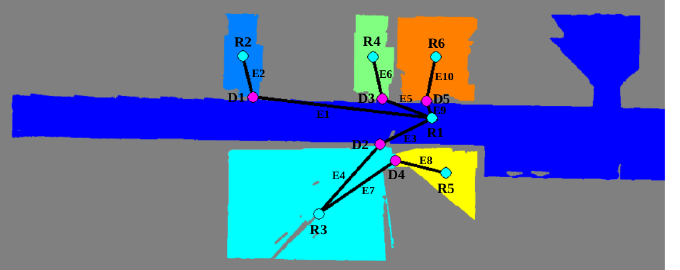
Figure 20. Resulting topological map overlapped with the segmented scenario. R and D correspond to room and door nodes, respectively, and E corresponds to